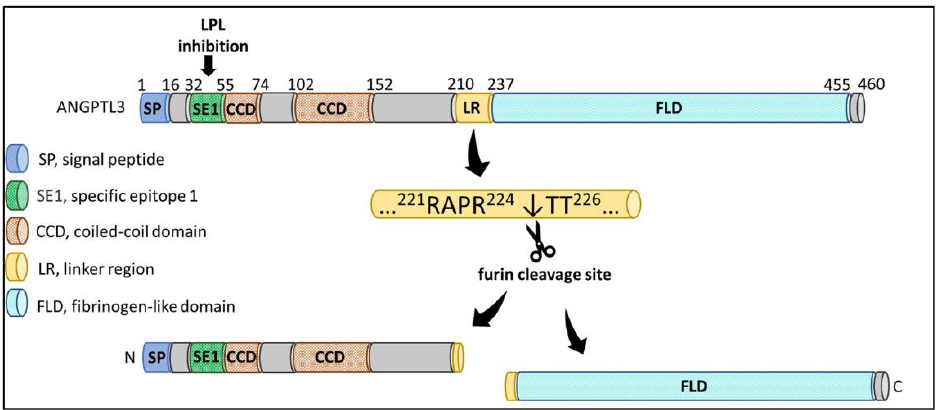
Figure 2. The structural features of ANGPTL3 protein. ANGPTL3 is composed of a signal peptide (SP), an N-terminal coiled-coil domain (CCD) involved in a specific epitope 1 (SE1) for LPL binding and inhibition, a linker region (LR), and a C-terminal fibrinogen-like domain (FLD) with angiogenic properties. The amino acid residues 221 RAPR 224 ↓ TT 226 within the LR could be cleaved by furin to yield a N-terminal CCD and a C-terminal FLD in hepatic cells (created with BioRender.com, accessed on 2 July